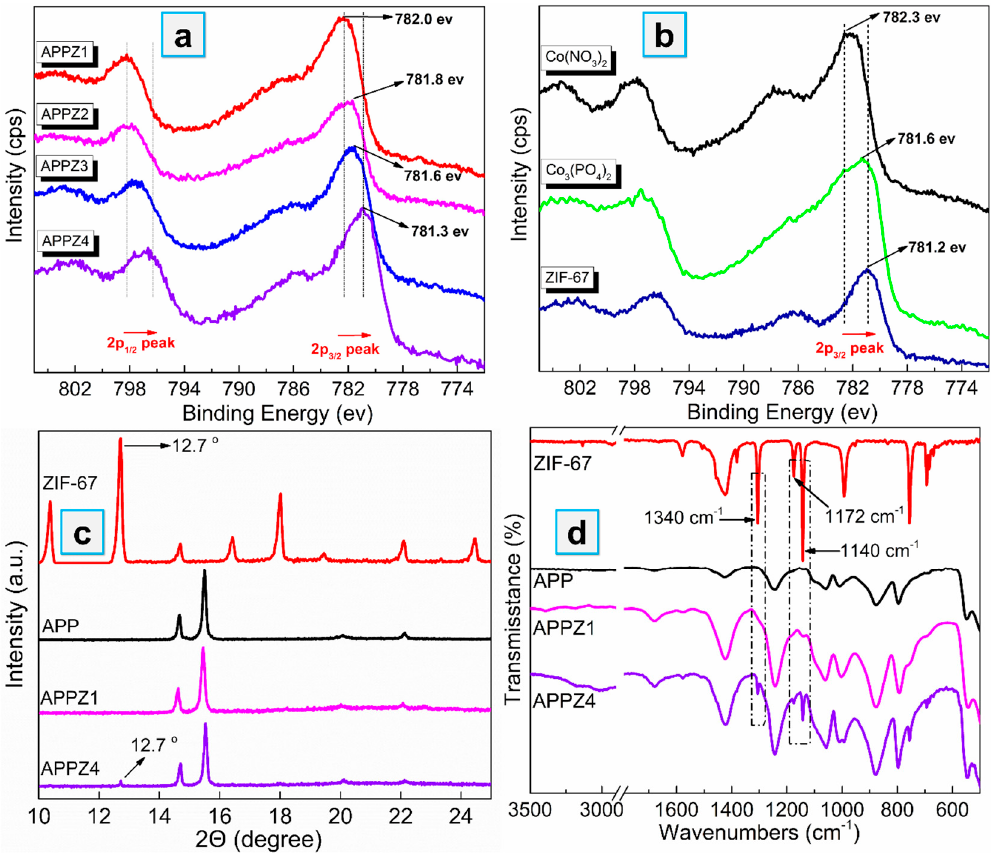
Figure 2. Co 2P X-ray photoelectron spectroscopy (XPS) spectrum ( a , b ), XRD patterns ( c ), and Fourier transform infrared (FTIR) spectra ( d ) of ZIF-67 and APP-ZIFs.